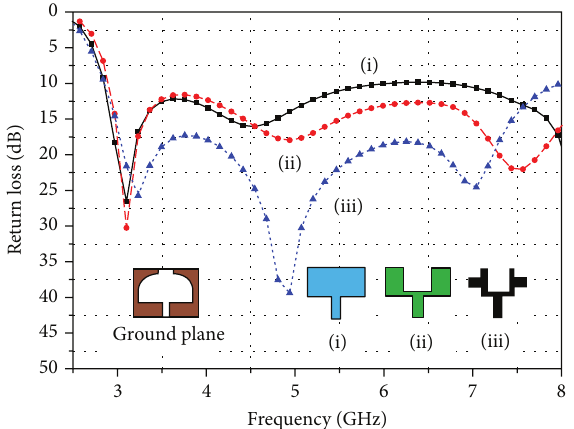
Figure 3: Simulated return loss against frequency for the rectangu- lar antenna, rectangular U shape antenna, and proposed CPW-fed two-sided T strip wideband microstrip